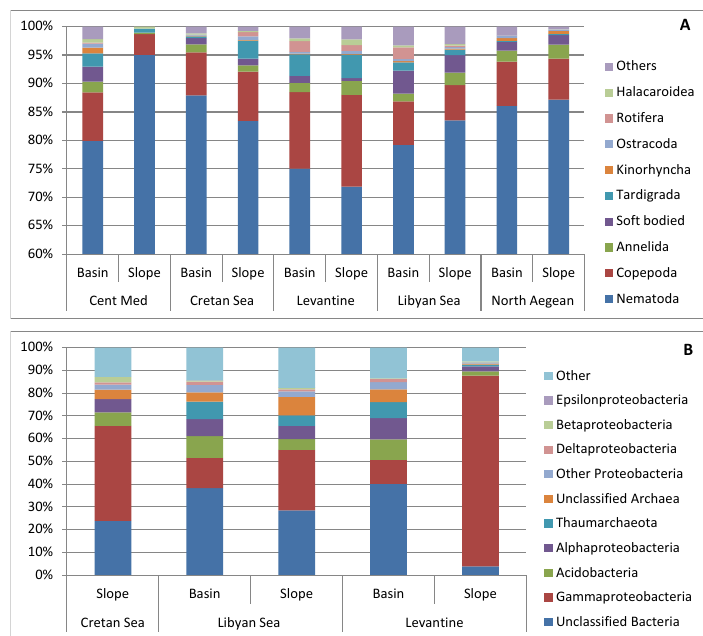
Fig. 2. Meiofauna (A) and microbial (B) composition per studied area and habitat.